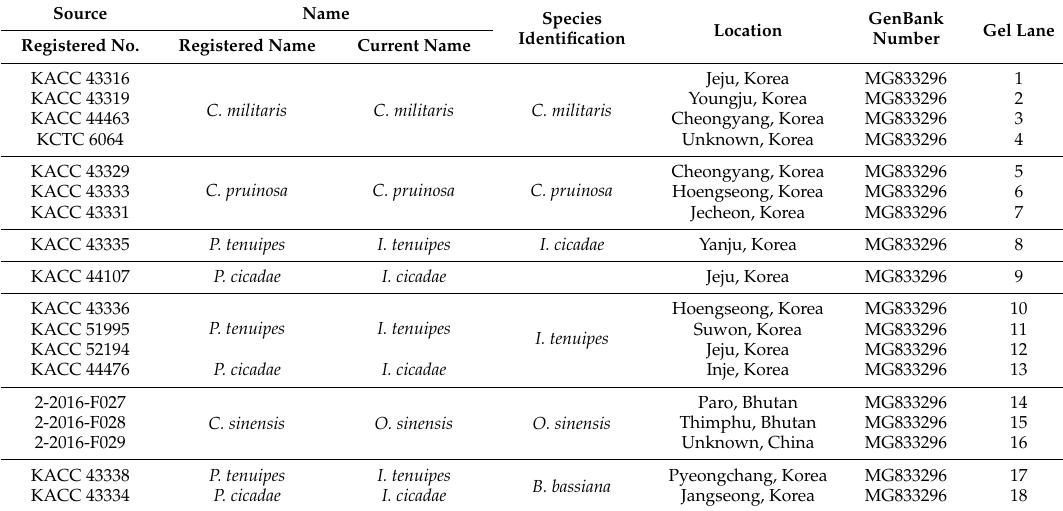
Table 1. Fungal material used in the current study.